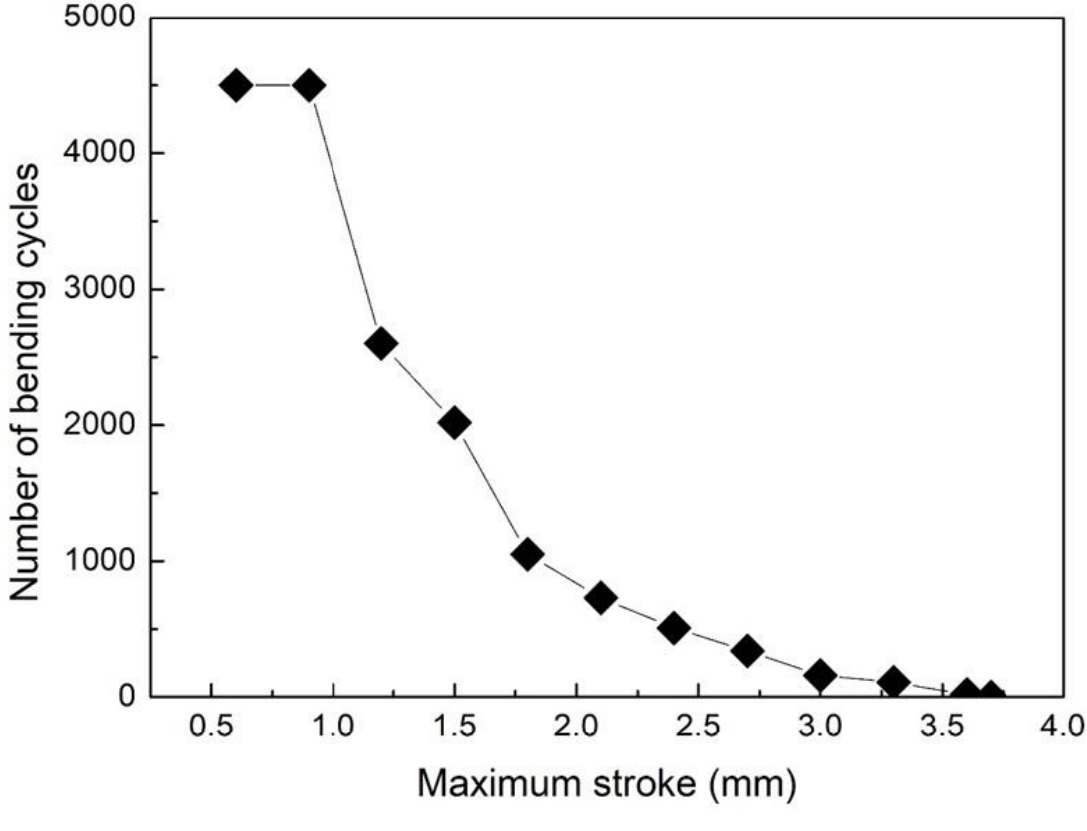
Figure 10. Number of cycles at which the first coating damage was observed at different maximum strokes.